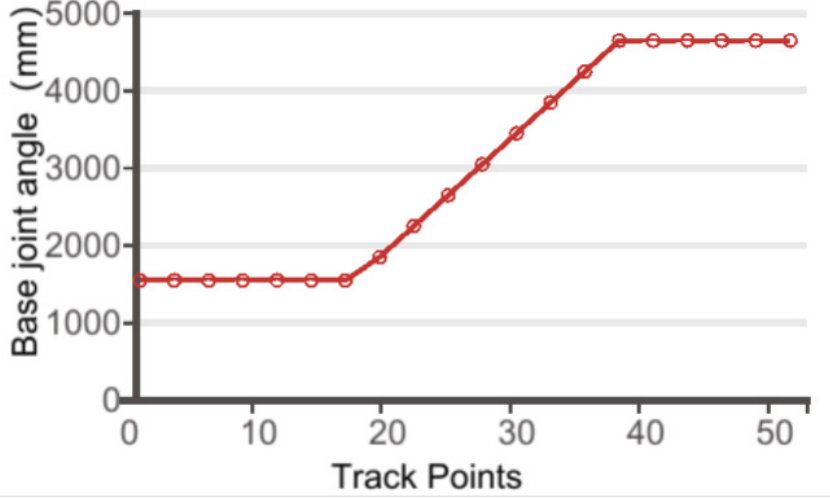
Figure 11. Base joint angle change process.